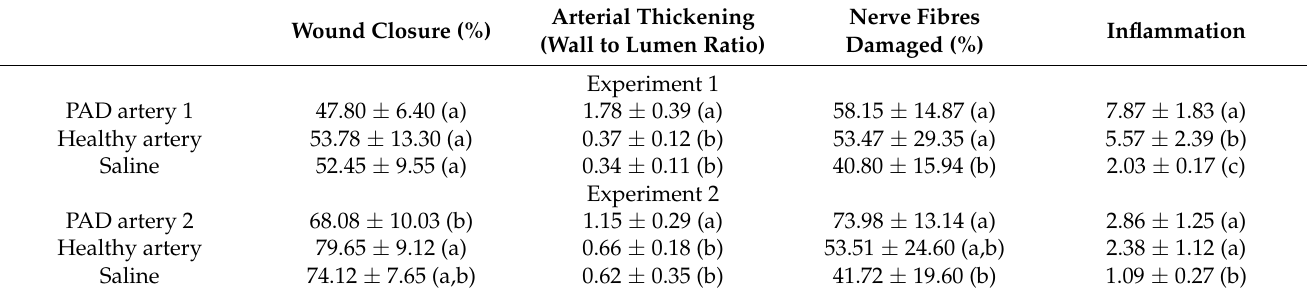
Table 3. Effect of peripheral artery disease arterial tissue homogenates on healthy rats’ granulation tissue histological appearance and wound healing